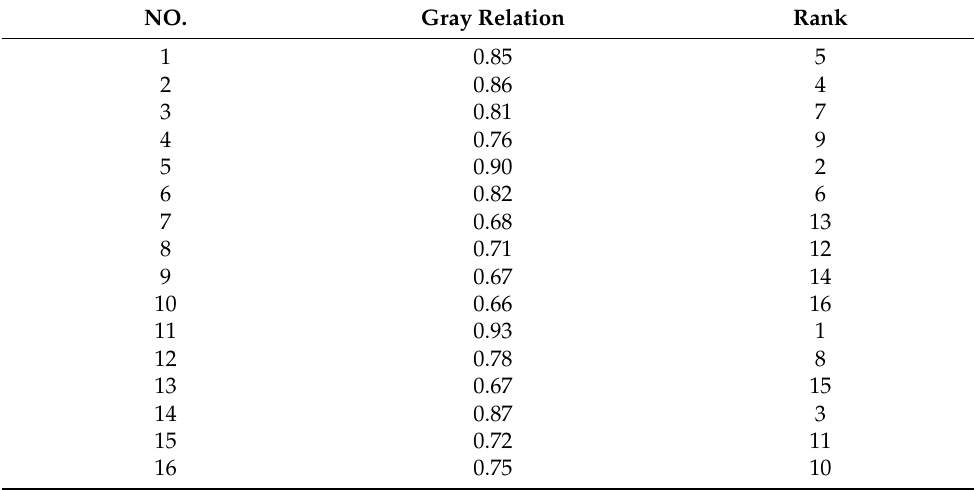
Table 15. Gray Correlation Degree and